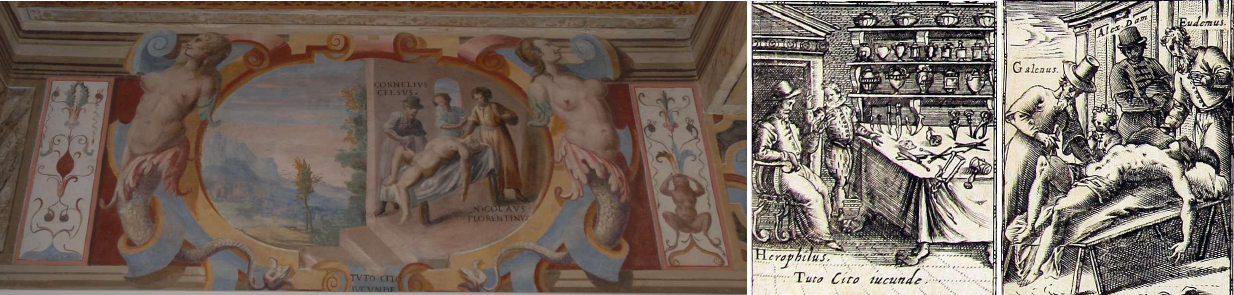
Figure 7. Left : Oval painting on the southern wall depicting Aulus Cornelius Celsus and Nicol ò Falcucci at work. Middle : Herophilos seated in front of a table on which the dissection instruments are exhibited; on the floor of the room where he sits is the inscription Tuto Cito Iucunde (frontispiece of Giunti’s edition). Right : Galen intent on dissecting a corpse under the gaze of Eudemus and Alessandro Damasceno (frontispiece of Giunti’s